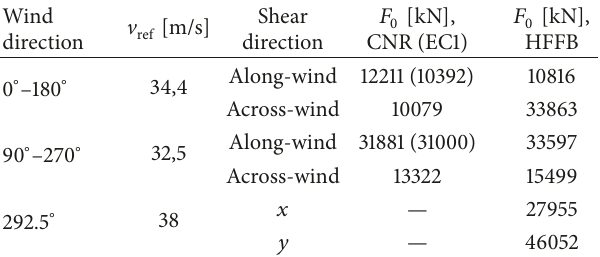
Table 4: Stress design acceleration.